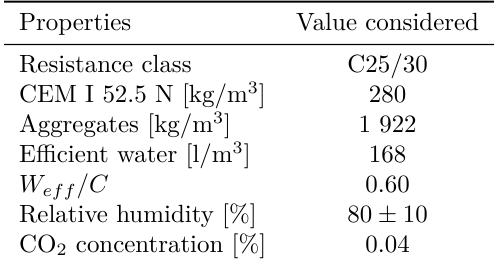
Table 3. Properties of studied concrete and